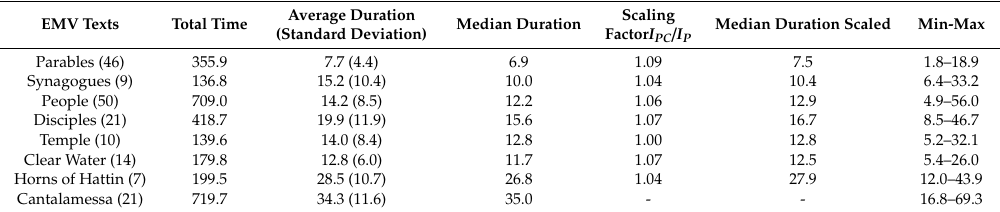
Table 2. Statistics of speech duration (in minutes). All values can change by approximately ± 3%, because of the Cantalamessa’s speaking speed